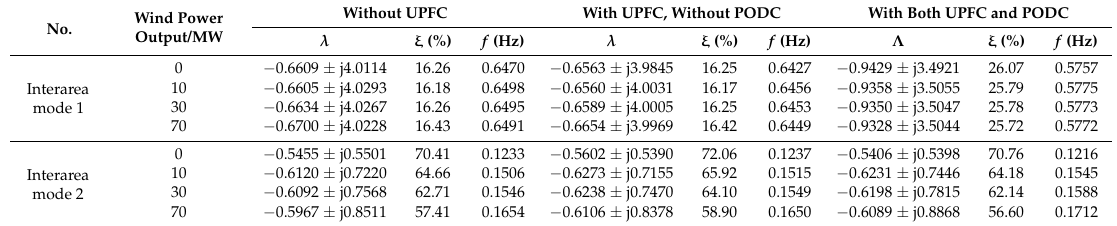
Table 5. The interarea oscillation modes under different DFIG outputs.